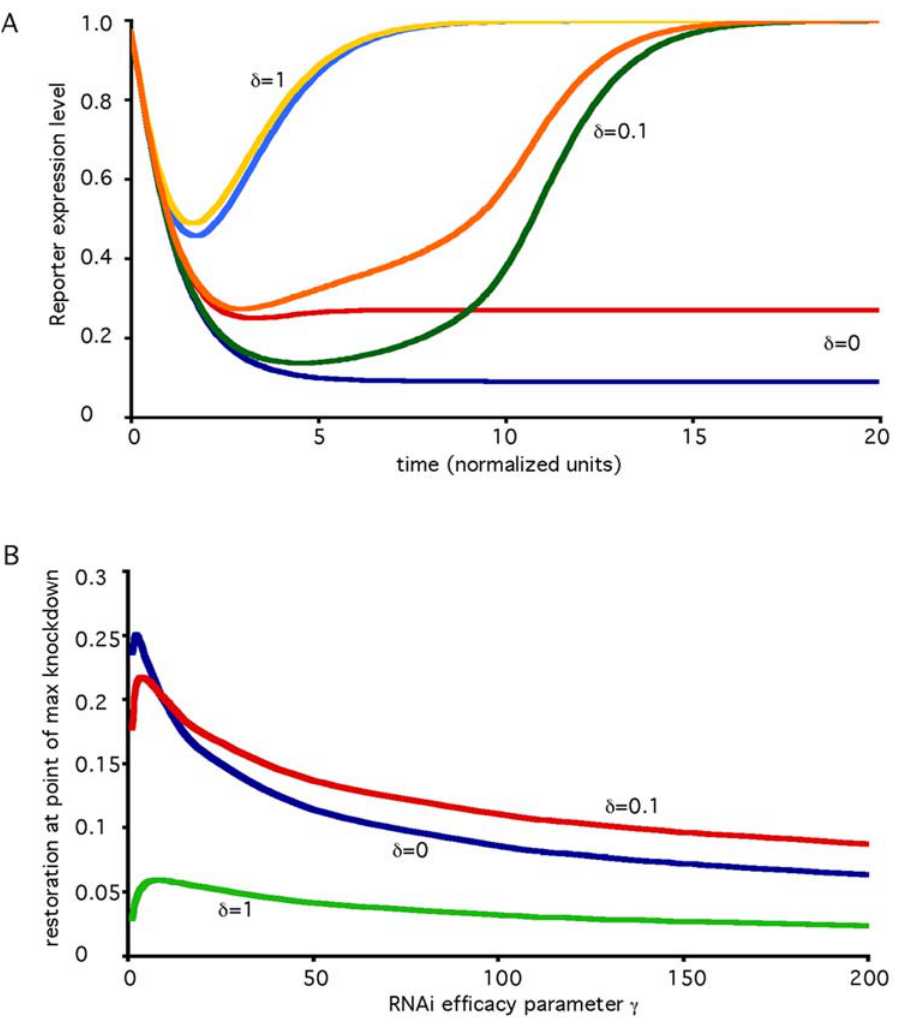
Figure 9. Modeling transient transfection experiments. (A) reporter gene expression levels with and without recursive RNAi of Dicer in which the source of dsRNA decays with first order kinetics to represent dilution of plasmids by cell division, with decay constant d . All simulations run with c =10. (Blue, green, light blue) targeting of reporter only without targeting of RNAi components. (Red, orange, yellow) targeting of Dicer along with the reporter. Decay of dsRNA source leads to transient reduction in reporter that restores at a rate dependent on decay rate of source. Rapid decay of dsRNA source leads to less difference between recursive and non-recursive RNAi (compare d =1, where almost no difference is seen when Dicer is also targeted, with a tenfold slower decay rate d =0.1, where Dicer targeting clearly increases expression level during transient knockdown). (B) Dependence of restoration on RNAi efficacy parameter c for different rates of dsRNA source (plasmid) decay.